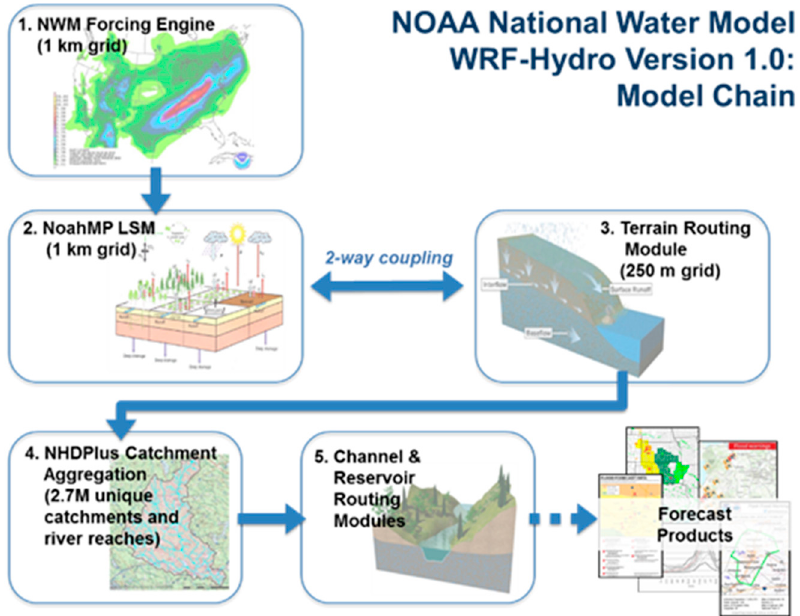
Figure 2. Diagram of complex hydrological processes of the National Water Model (NWM) [28].